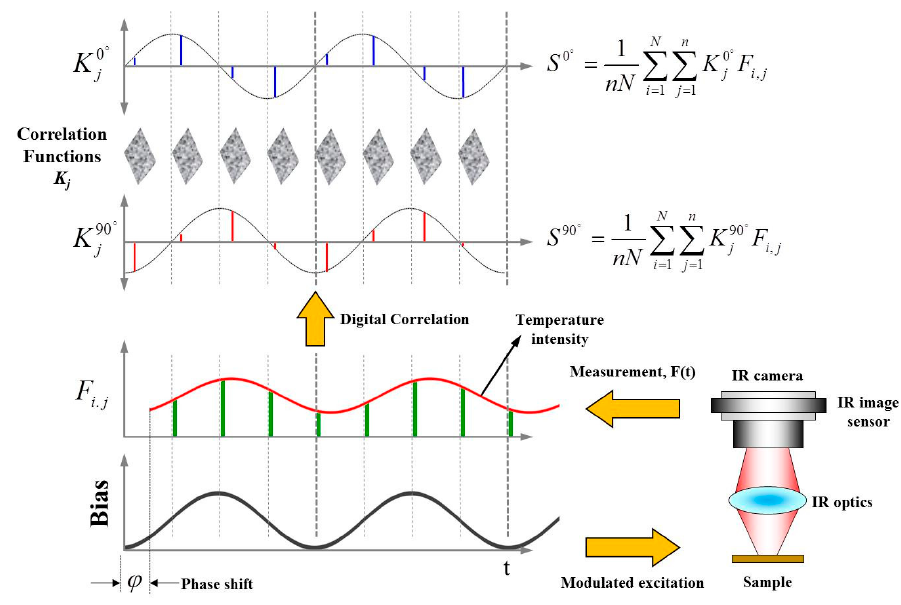
Figure 1. Working principle of an infrared lock-in operation.